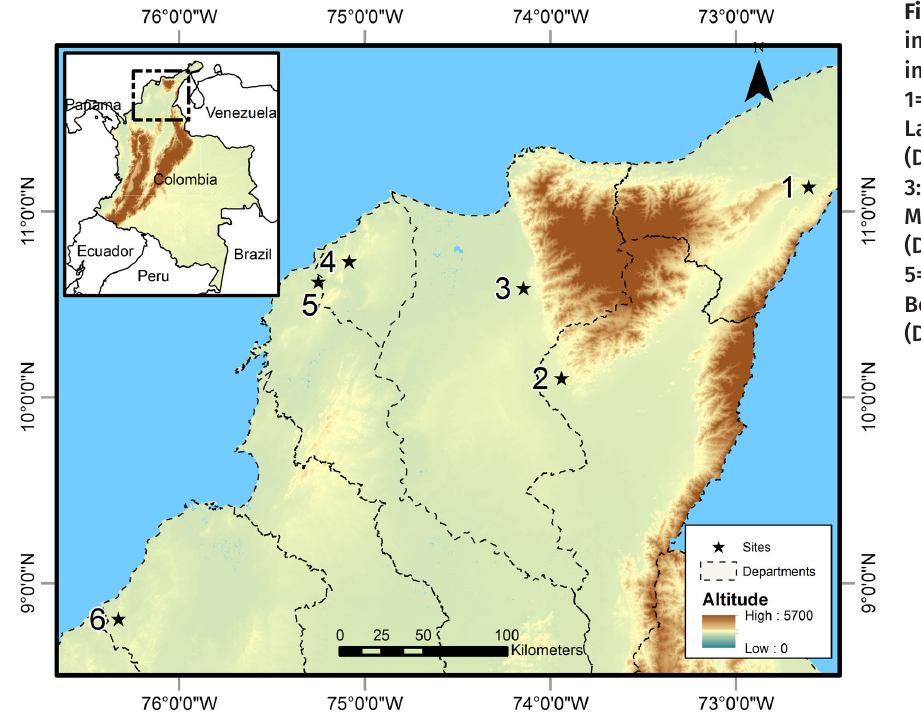
Figure 1. Study sites in tropical dry forest in northern